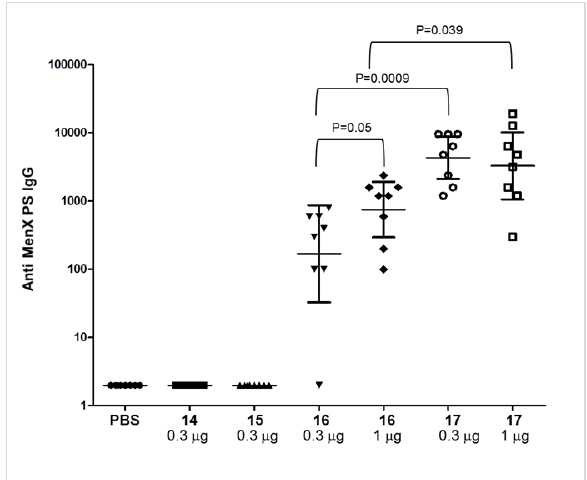
Figure 2: IgG levels detected at OD = 1 in individual post 3 sera (sera collected two weeks after the third immunization) of BALB/c mice immunization at 0.3 or 1 μ g saccharide dose of antigen against MenX CPS as coating plate. Each dot represents individual mouse sera; hori- zontal bars indicate geometric mean titers (GMT) of each group with 95% statistical confidence intervals indicated by upper and lower bars.